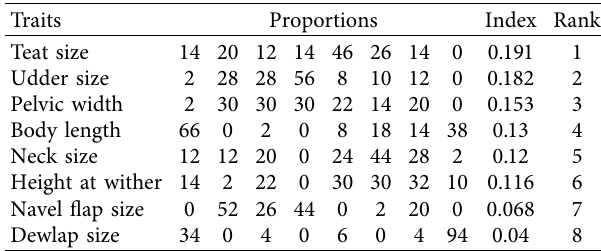
Table 3: Selection criteria of dairy cows in Gechi district.